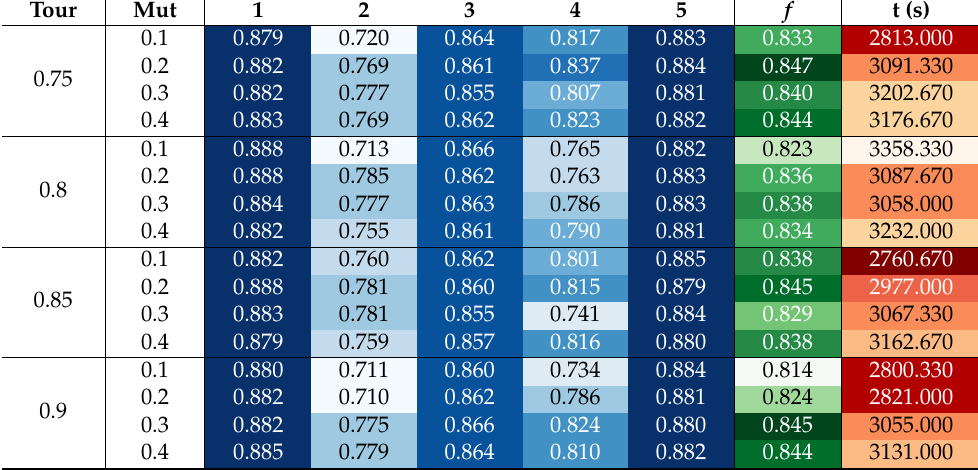
Table A1. Calibration results for map 520. Colored columns show fitness averages for each step (identified by step number), average over all steps ( ¯ f ), and runtimes (in seconds). Each row is a combination of two parameters: tournament probability (tour) and mutation rate (mut).